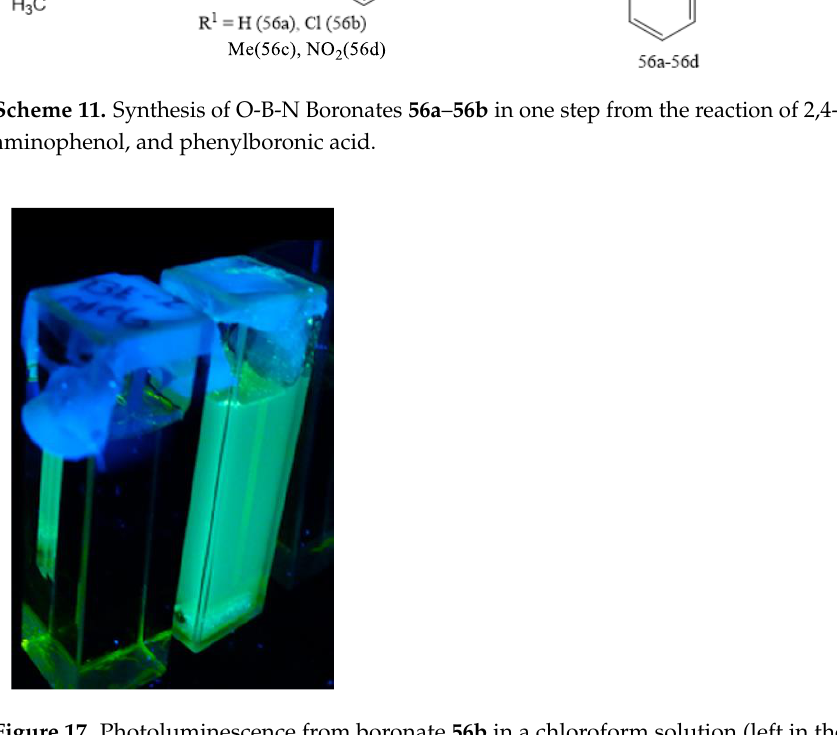
Figure 17. Photoluminescence from boronate 56b in a chloroform solution (left in the picture) and from a colloidal solution of nanocrystals (right in the picture). Fluorescence was obtained under excitation at 370 nm.